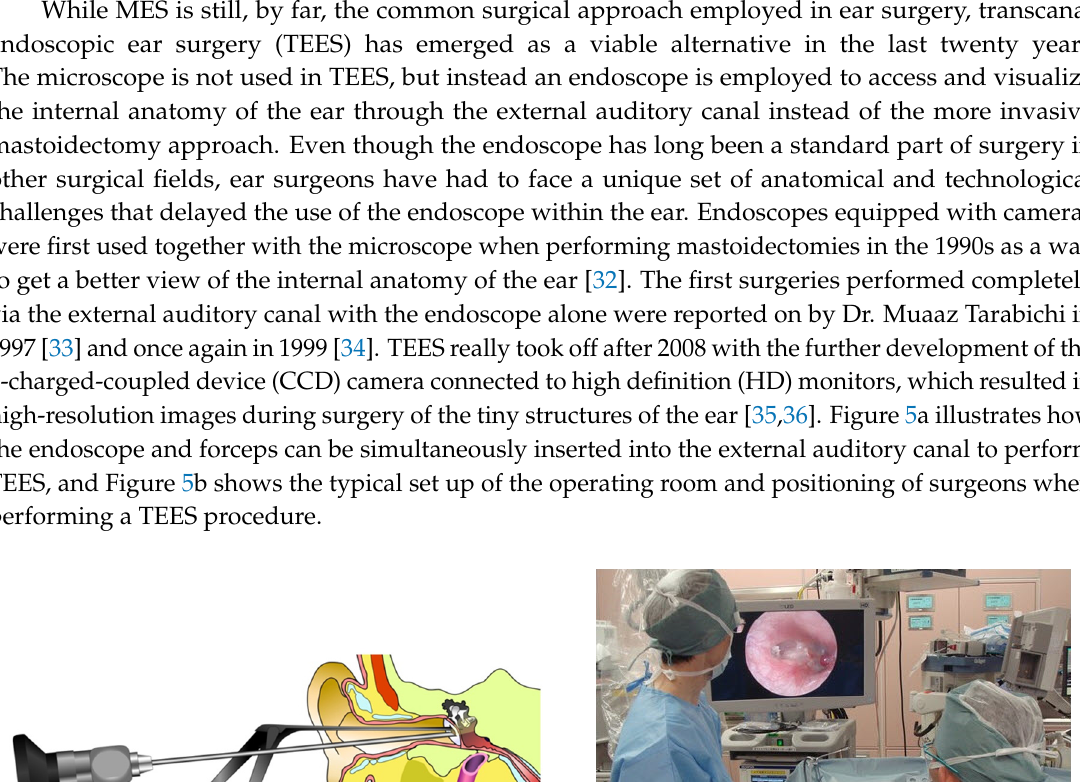
Figure 4. Microscopic ear surgery (MES) ( a ) A mastoidectomy in progress. ( b ) Surgeons performing MES.